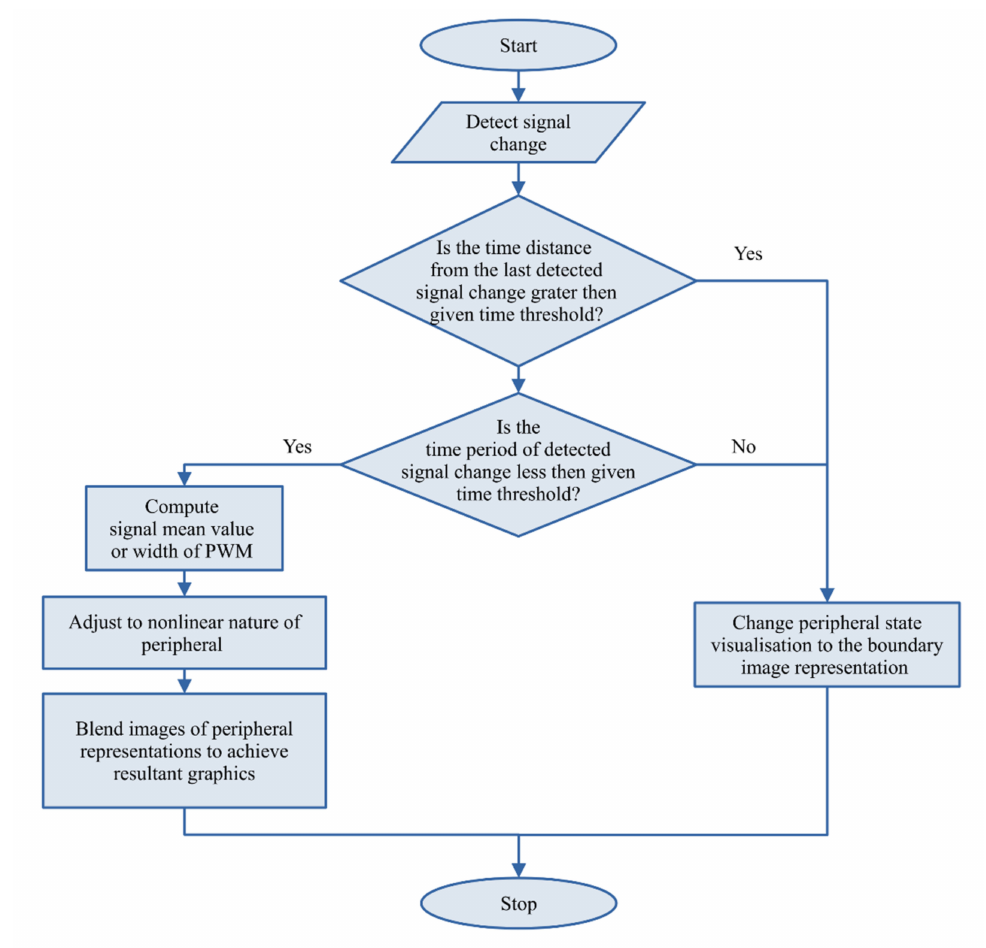
Figure 4. An algorithm of proper graphical visualization of peripherals in their real appearance regarding the input signal